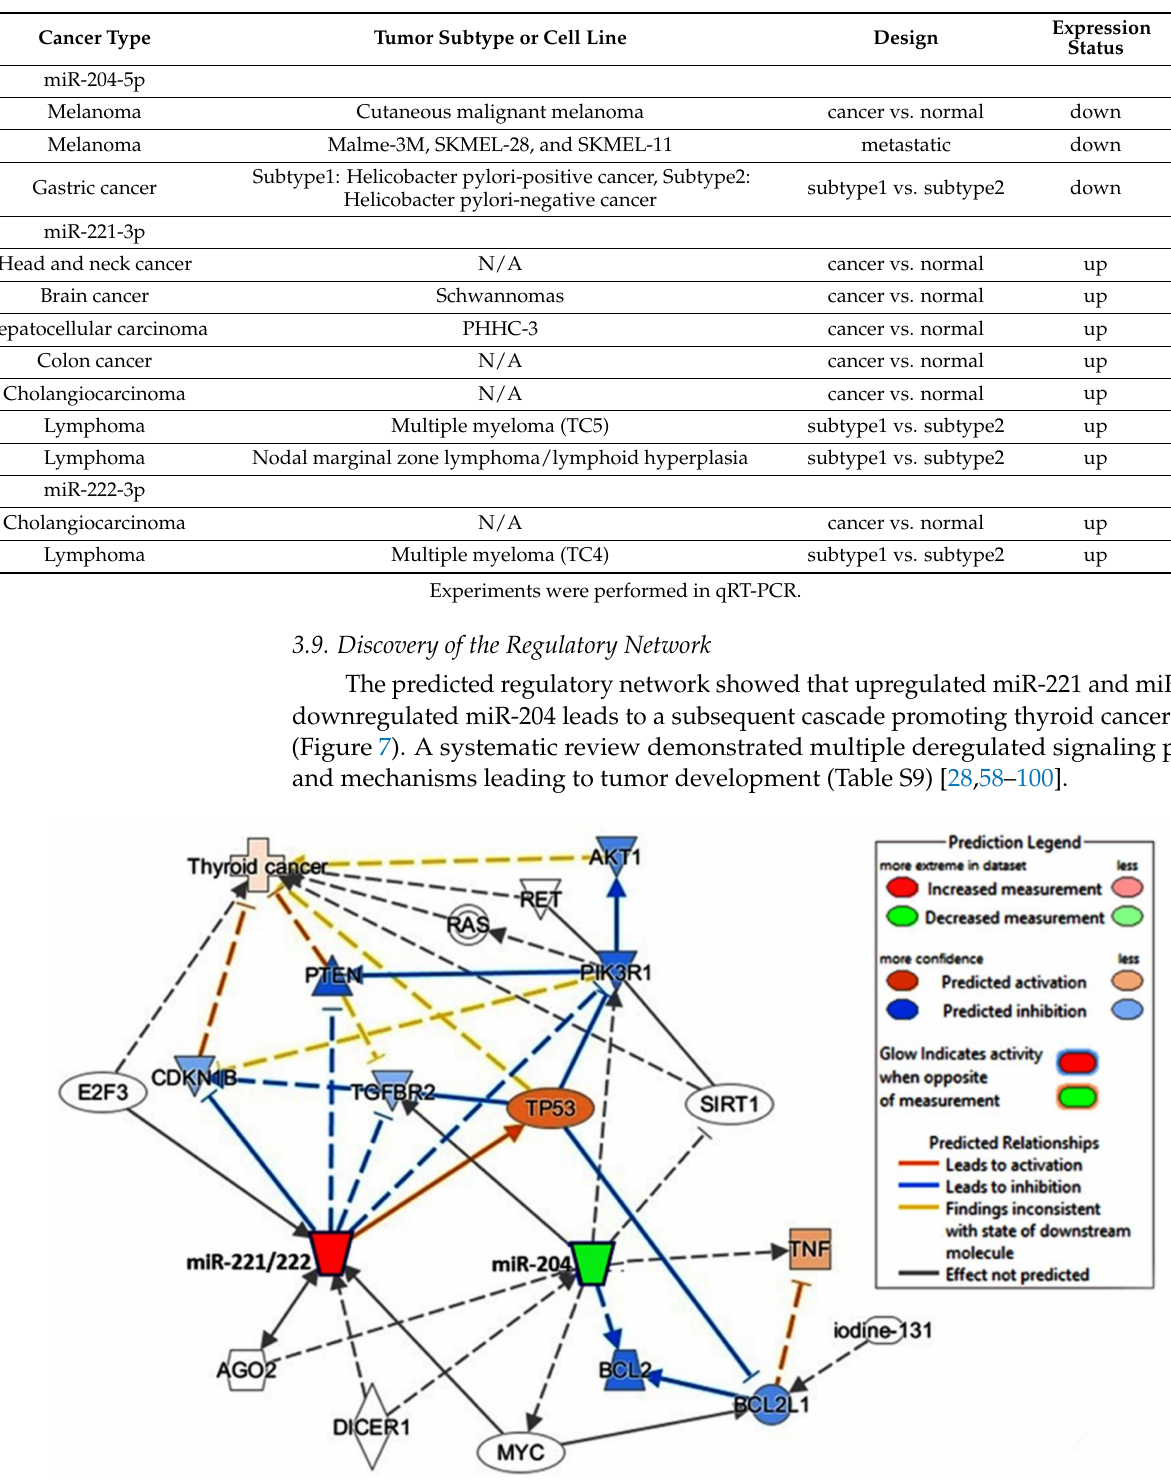
Table 7. Literature review of deregulated study microRNAs in cancer.